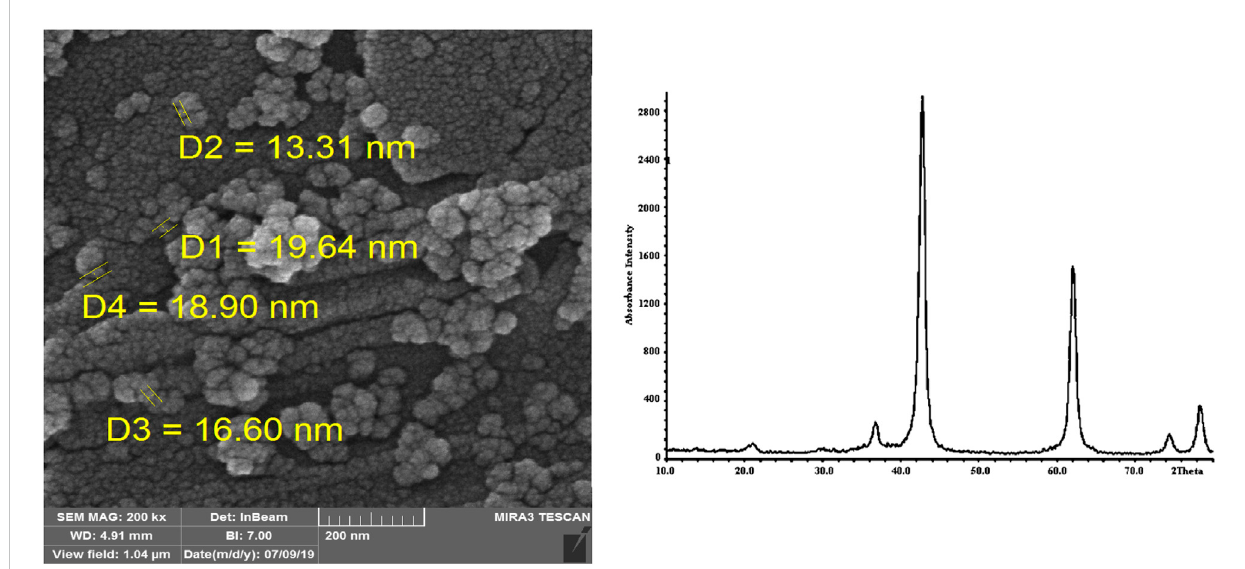
FIGURE 4 SEM image and XRD pattern of magnesium oxide nanoparticles after separating, washing, and drying.